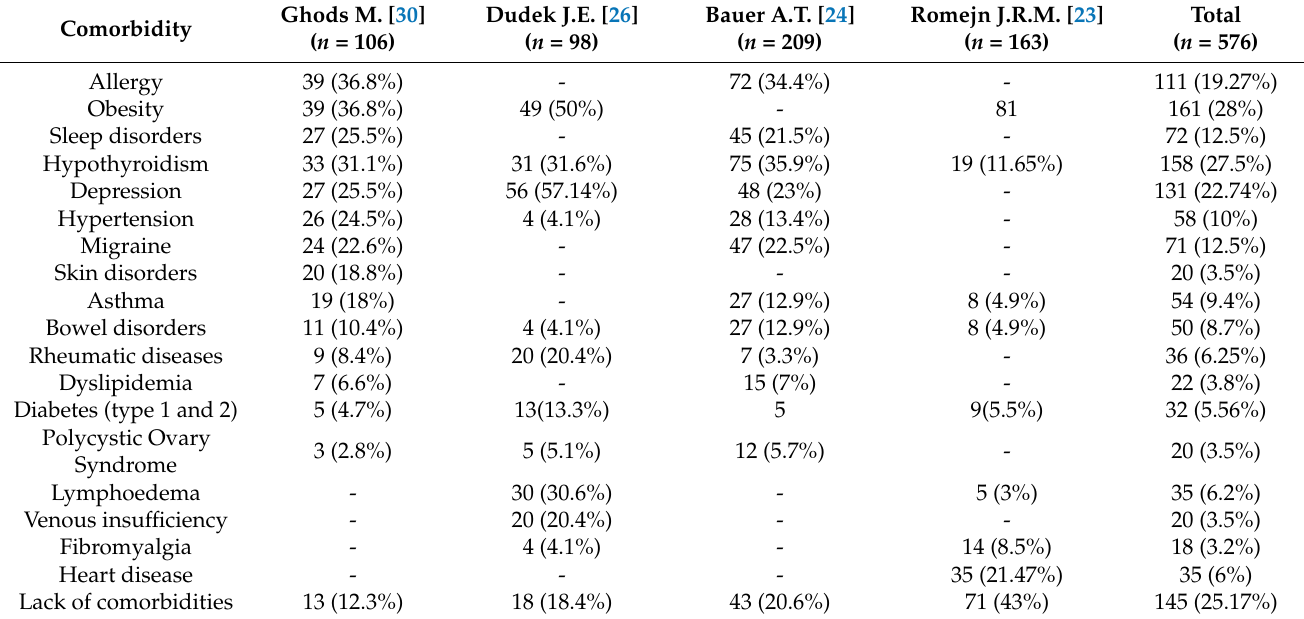
Table 3. Occurrence of comorbidities among people with